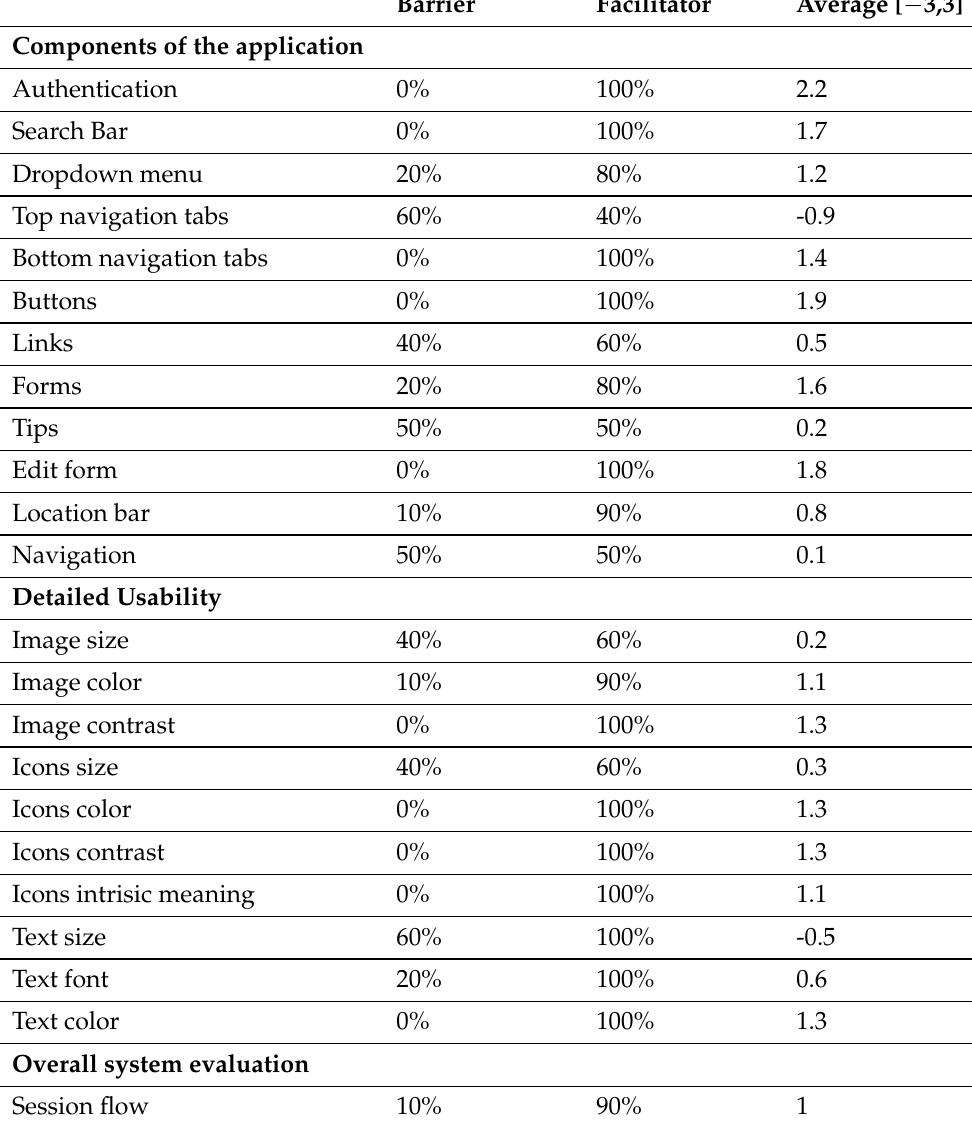
Table 9. ICF-US II